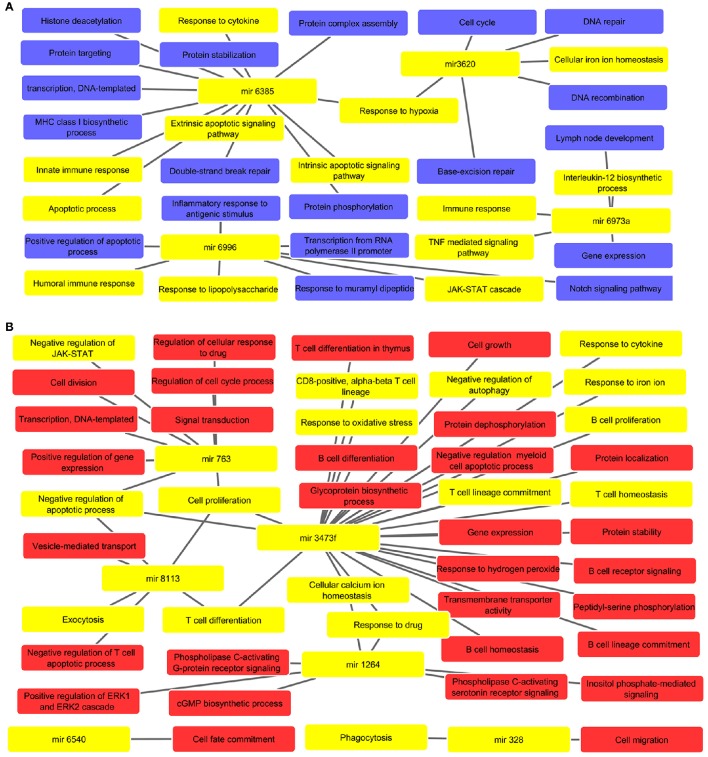
(A) Predicted biological processes of up regulated miRNAs after GO enrichment. The interlinked miRNAs and important pathways linked to macrophages effector functions such as phagocytosis, ROS metabolic process, B/T cell differentiation, etc. during pathogenic invasion are highlighted with yellow color. (B) The interaction of down regulated miRNAs and their targeted biological processes. The highlighted yellow color denotes interlinked miRNAs with key biological processes relevant to macrophage dysfunction such as cytokine response, immune response, negative regulation of apoptotic process, response to oxidative stress, etc.